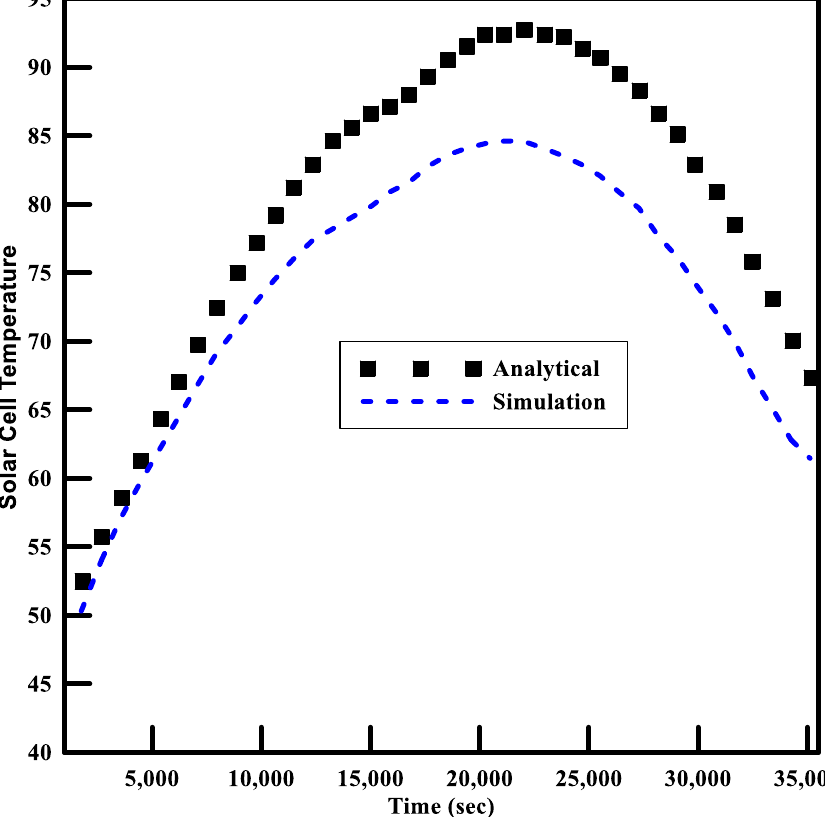
Figure 12. Simulation vs. analytical results for uncooled PV panel.